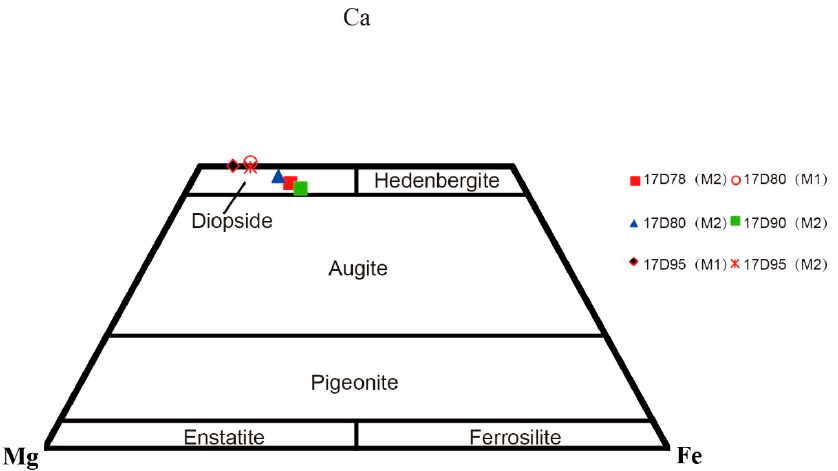
Figure 5. Classification of clinopyroxene in different samples (classification of